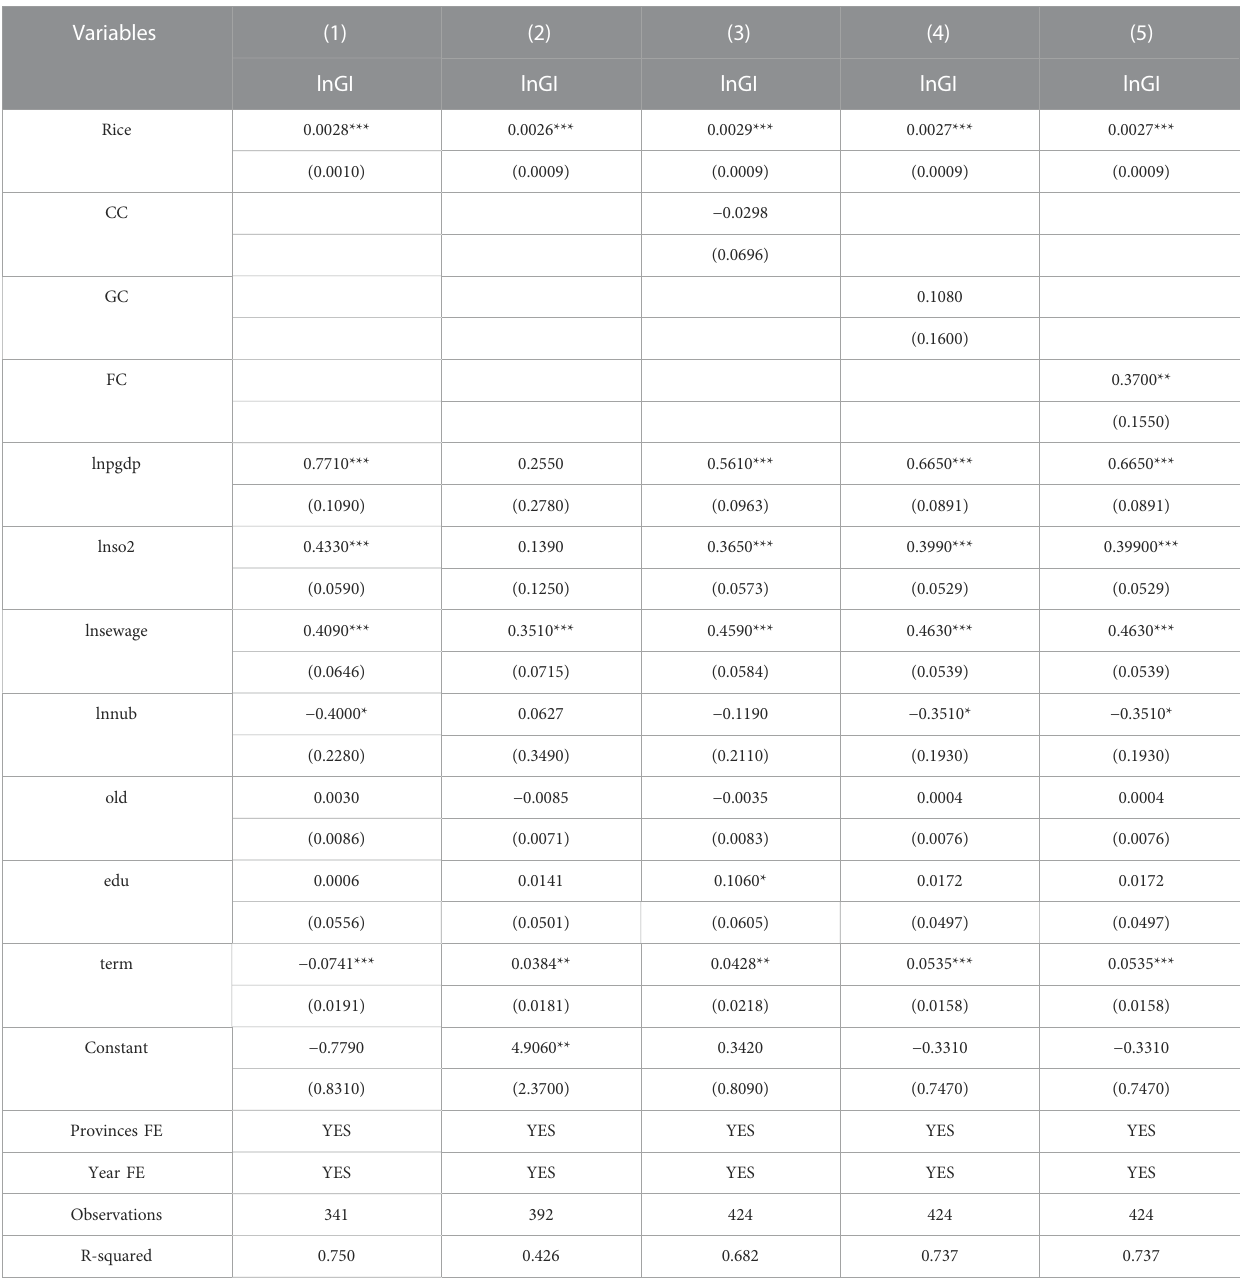
TABLE 3 Robustness